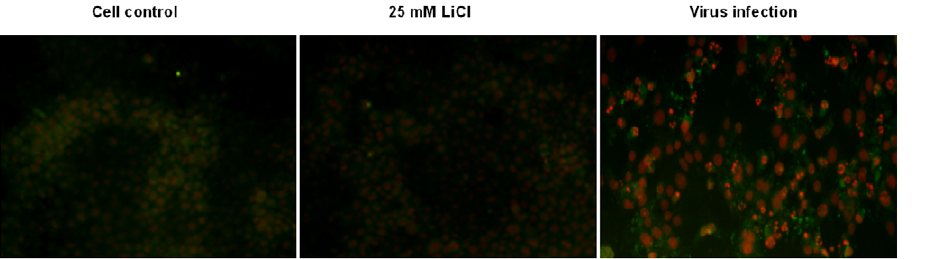
Figure 9. Expression of caspase-3 detected by immunofluorescence. The expression of caspase-3 on cells was analyzed using immunofluorescence. ST cells on 24-well plates were infected with TGEV for 1 h. Then the cells were treated with LiCl for 40 h followed by incubation with anti-caspase-3 antibody and FITC-conjugated secondary antibody. The nuclei were stained with propidium iodide prior to microscopic observation.